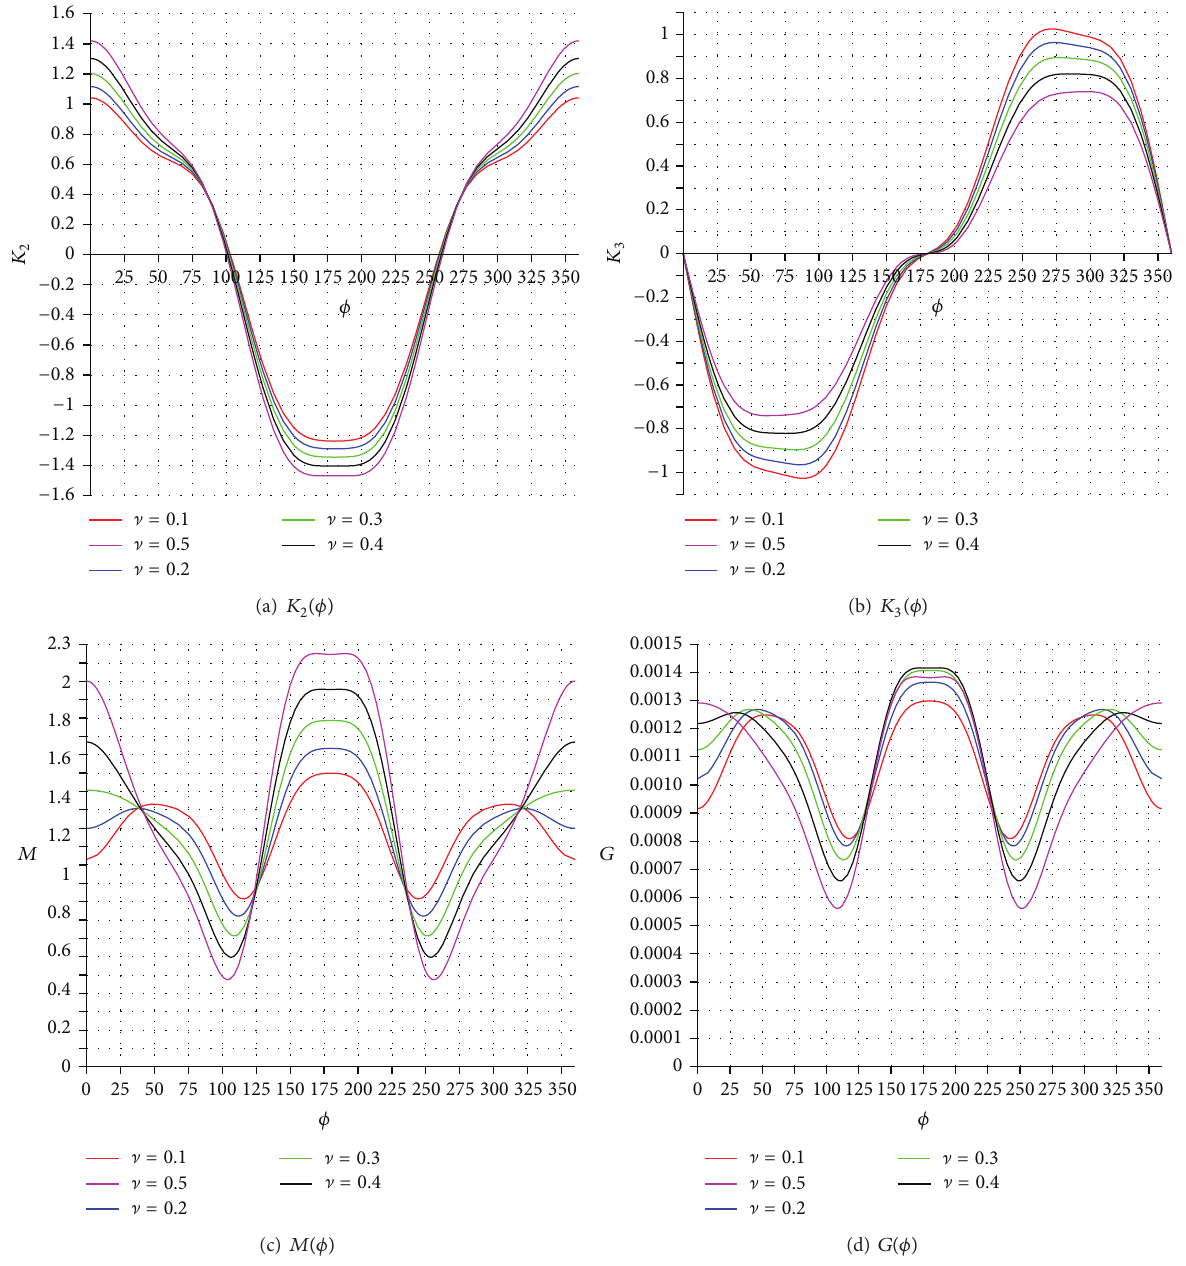
Figure 9: The 𝐾 2 (𝜙) , 𝐾 3 (𝜙) , 𝑀(𝜙) , and 𝐺(𝜙) for 𝑓(𝜁) = 𝜁 + 0.1𝜁 4 at various ] with 𝜇 = 1